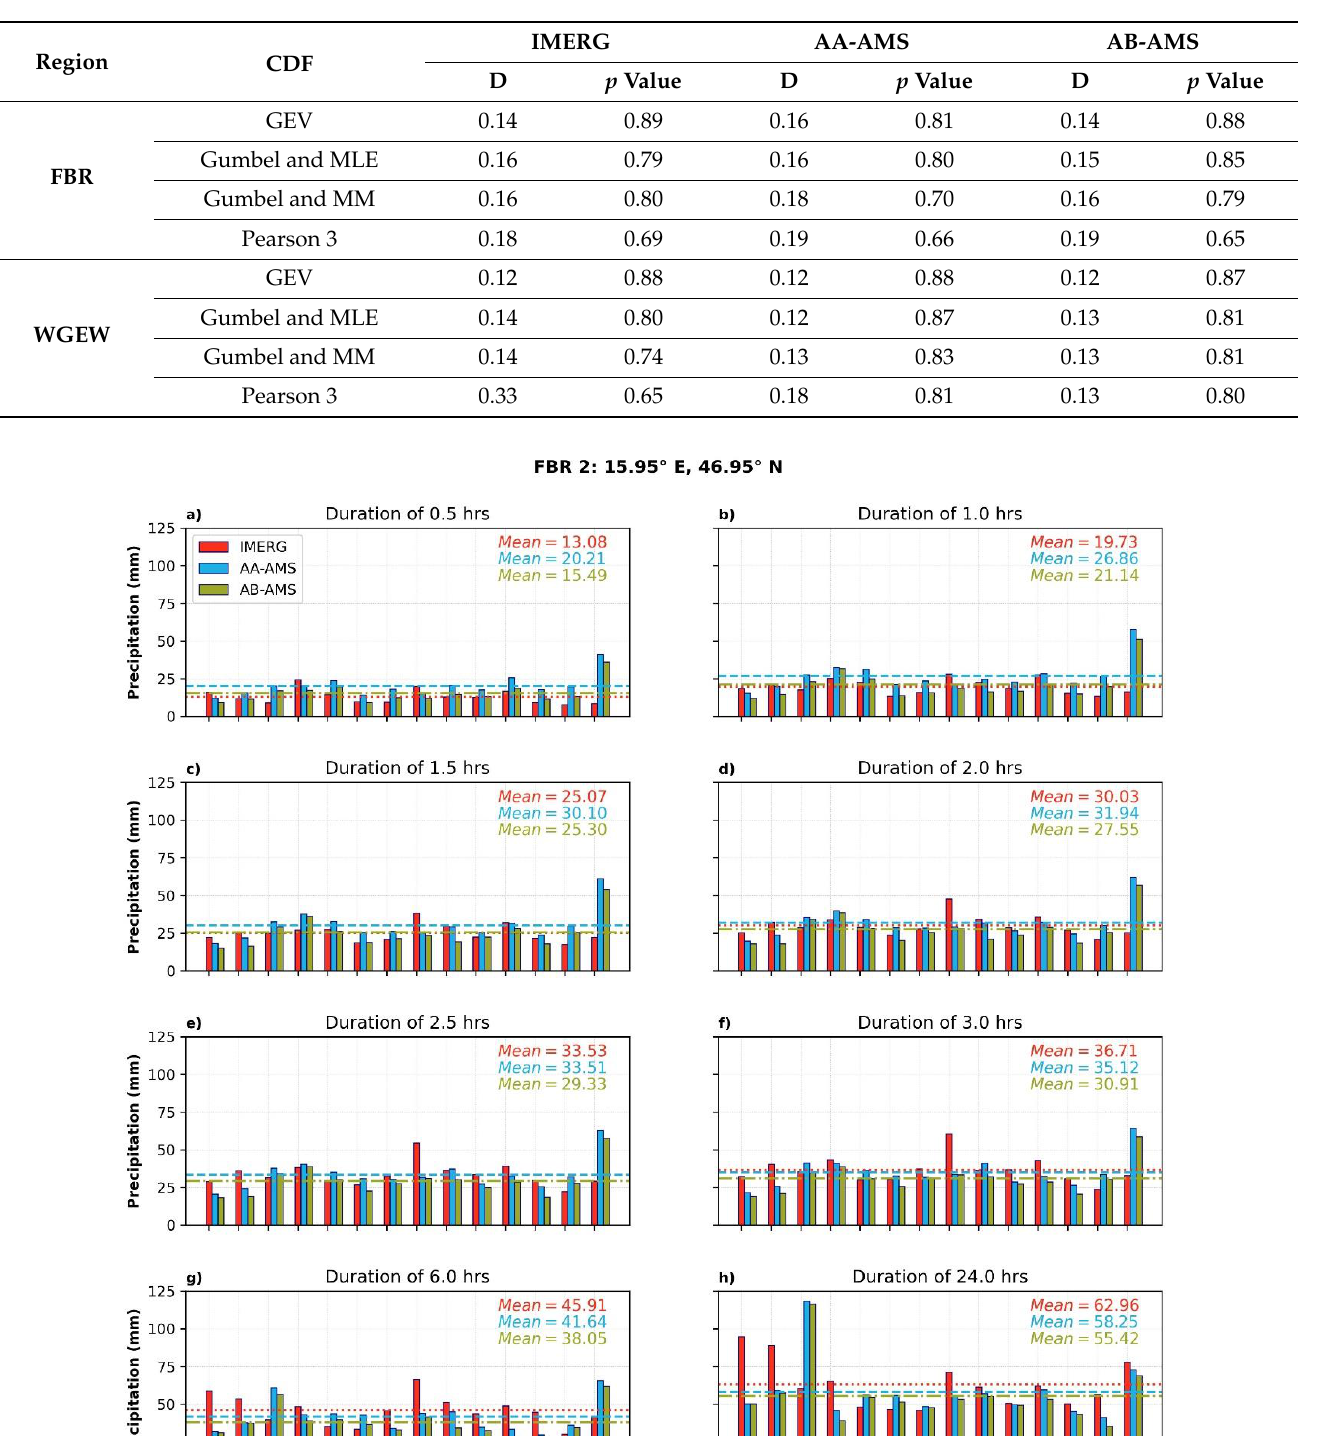
Table 5. Kolmogorov–Smirnoff test statistics (D) and p values according to the CDFs.